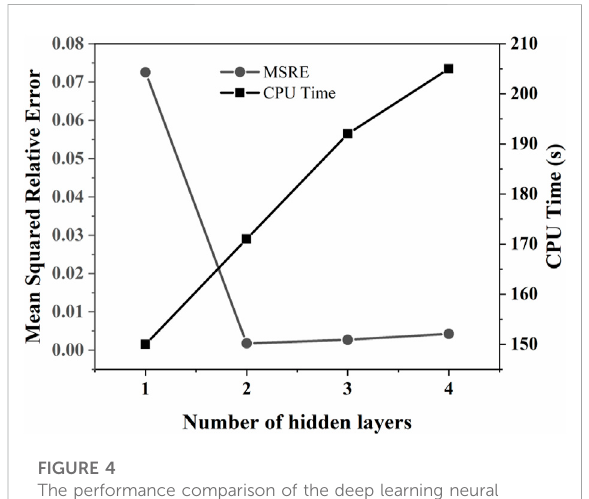
FIGURE 6 The variation oftheloss functionofthedeeplearningmodels during the training